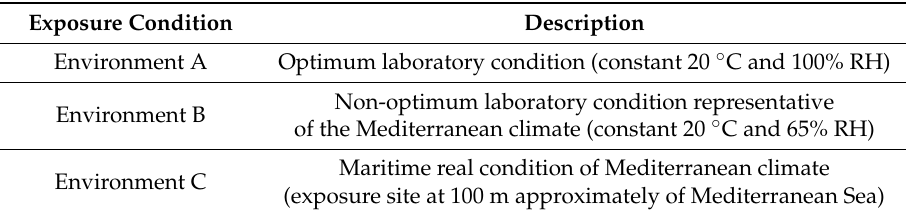
Table 2. Characteristics of environmental conditions